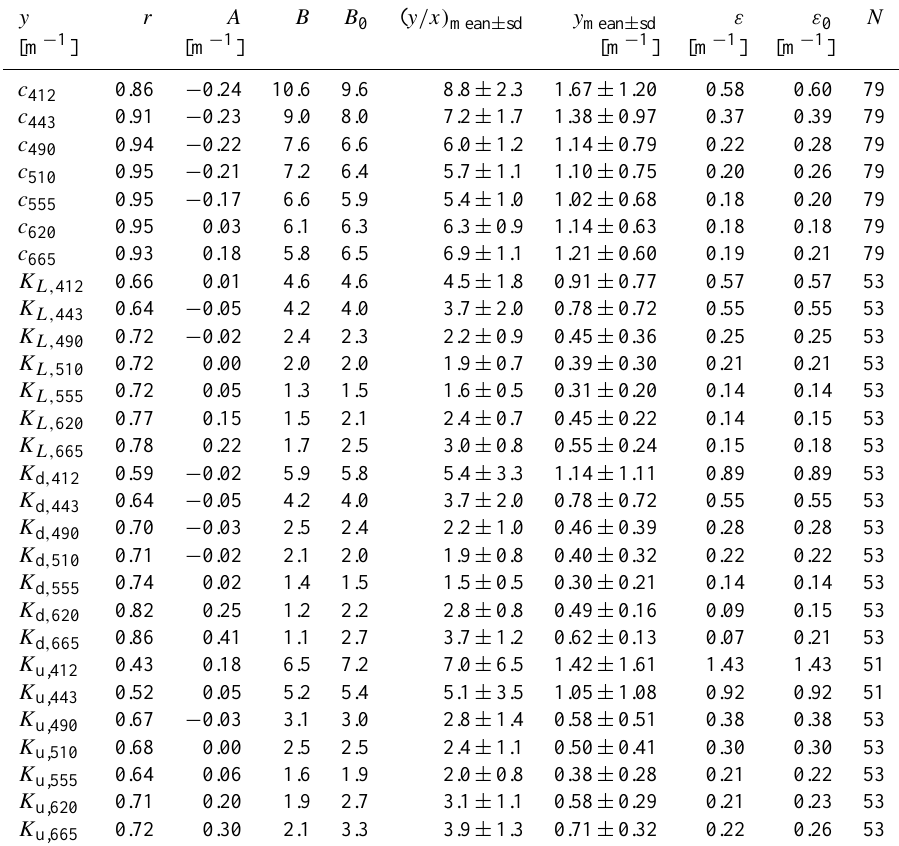
Table 6. Relationships of the forms y = A + Bx and y = B 0 x , where A , B and B 0 are coefficients from the correlation analysis between y and x = 1 /Z D,white . The error ε is the root mean square of the deviations ( y – A – Bx ), and ε 0 is the rms of ( y – B 0 x) . r is the correlation coefficient and N is the number of